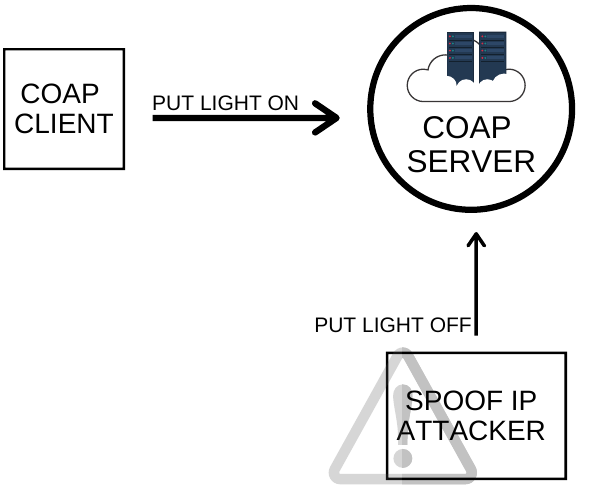
Figure 5. Constrained Application Protocol (COAP) replay